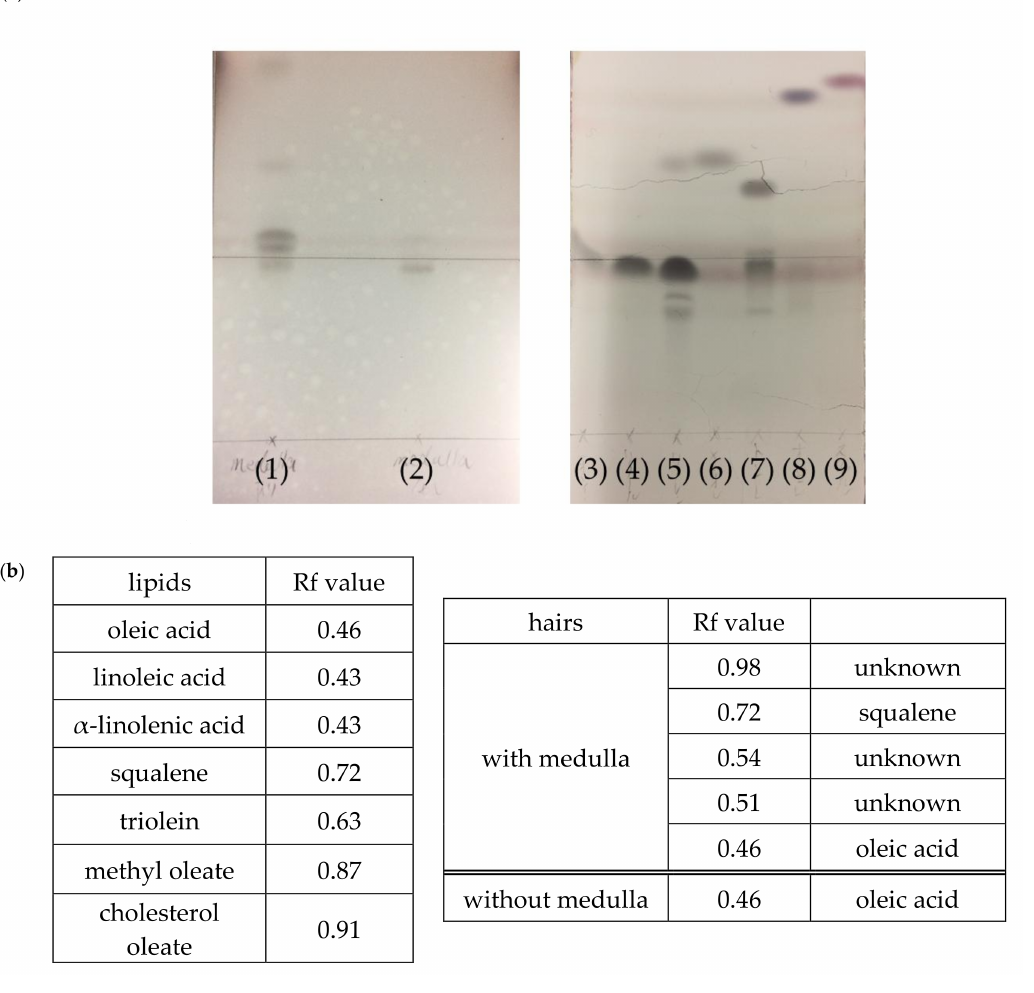
Figure 6. ( a ) Lipid analysis of hair with and without the medulla using thin-layer chromatography (TLC). Designations in Figure 6a: (1) hairs with the medulla; (2) hairs without the medulla; (3) oleic acid; (4) linoleic acid; (5) α -linolenic acid; (6) squalene; (7) triolein; (8) methyl oleate; and (9) cholesterol oleate. ( b ) Rf (relative to front) values for lipid standards and lipids obtained by lipid extraction from hair with and without the medulla, as described in the Section